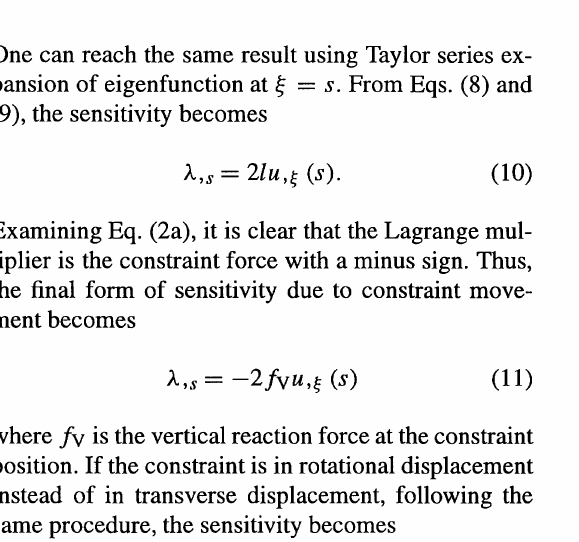
FIGURE 3 Shape variation of combined two